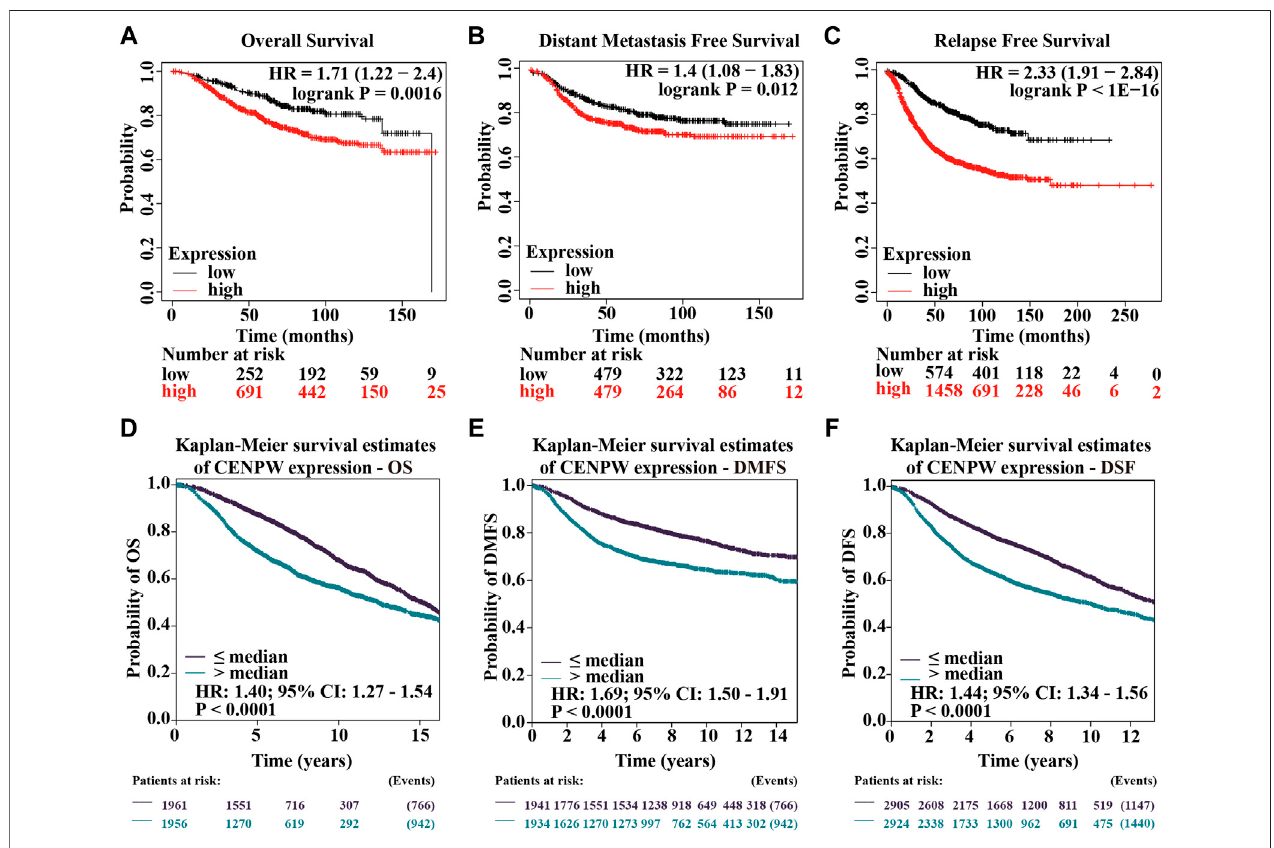
FIGURE4| Survivaldataassessingtheprognosticvalueof CENPW .Kaplan-Meiersurvivalanalysisof (A) OS, (B) DMFSand (C) RFSinbreastcancer.Andsurvival analysis of (D) OS, (E) DMFS and (F) DFS analyzed by bc-GenExMiner database in patients with breast cancer.